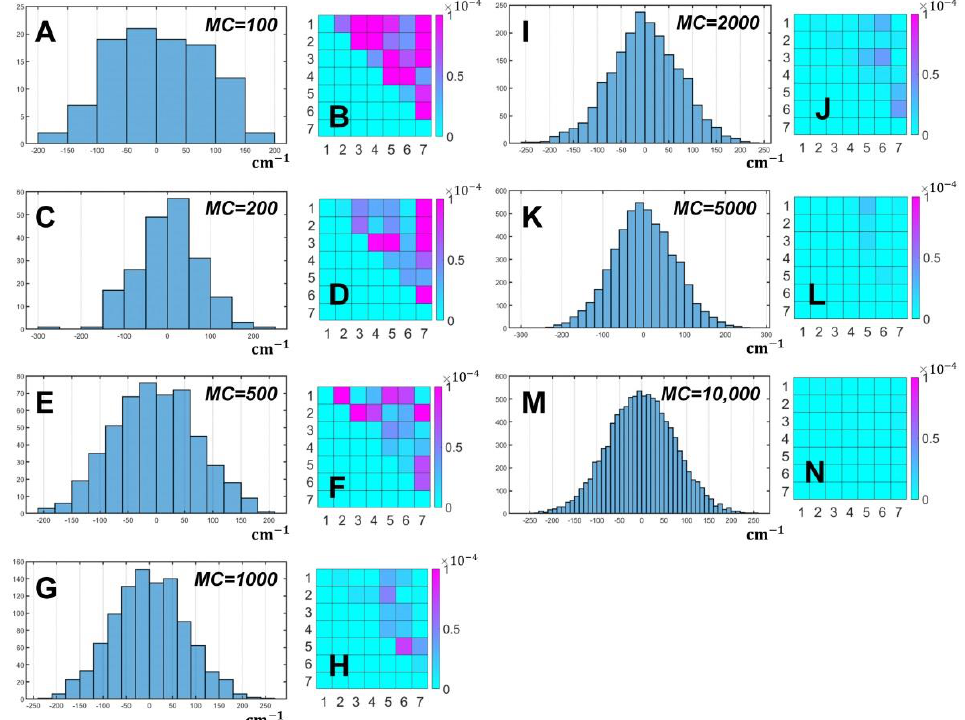
Figure 2. Distribution of the fluctuation parameter 𝛿 1𝑗 for the first transition energy Ω 1 in the Hamiltonian (5) for the following MC values: 100 ( A ), 200 ( C ), 500 ( E ), 1000 ( G ), 2000 ( I ), 5000 ( K ), 10,000 ( M ). For each MC, absorption spectrum of PSIIRC was simulated seven times, and then the spectra were compared with each other by calculating 𝜒 2 for each pair of 21 combinations of the spectra. The resulting matrices of 𝜒 2 are shown for MC=100 ( B ), 200 ( D ), 500 ( F ), 1000 ( H ), 2000 ( J ), 5000 ( L ), 10,000 ( N ). Color bars reflect the variations of 𝜒 2 .